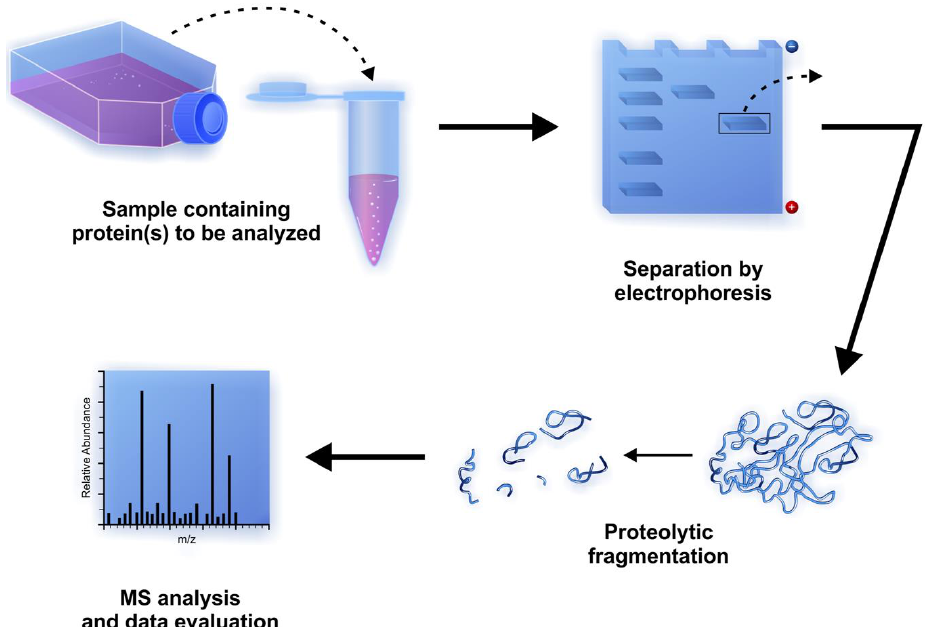
Figure 4. Steps of proteomic analysis using mass-spectrometry after separation and in-gel digestion of proteins of